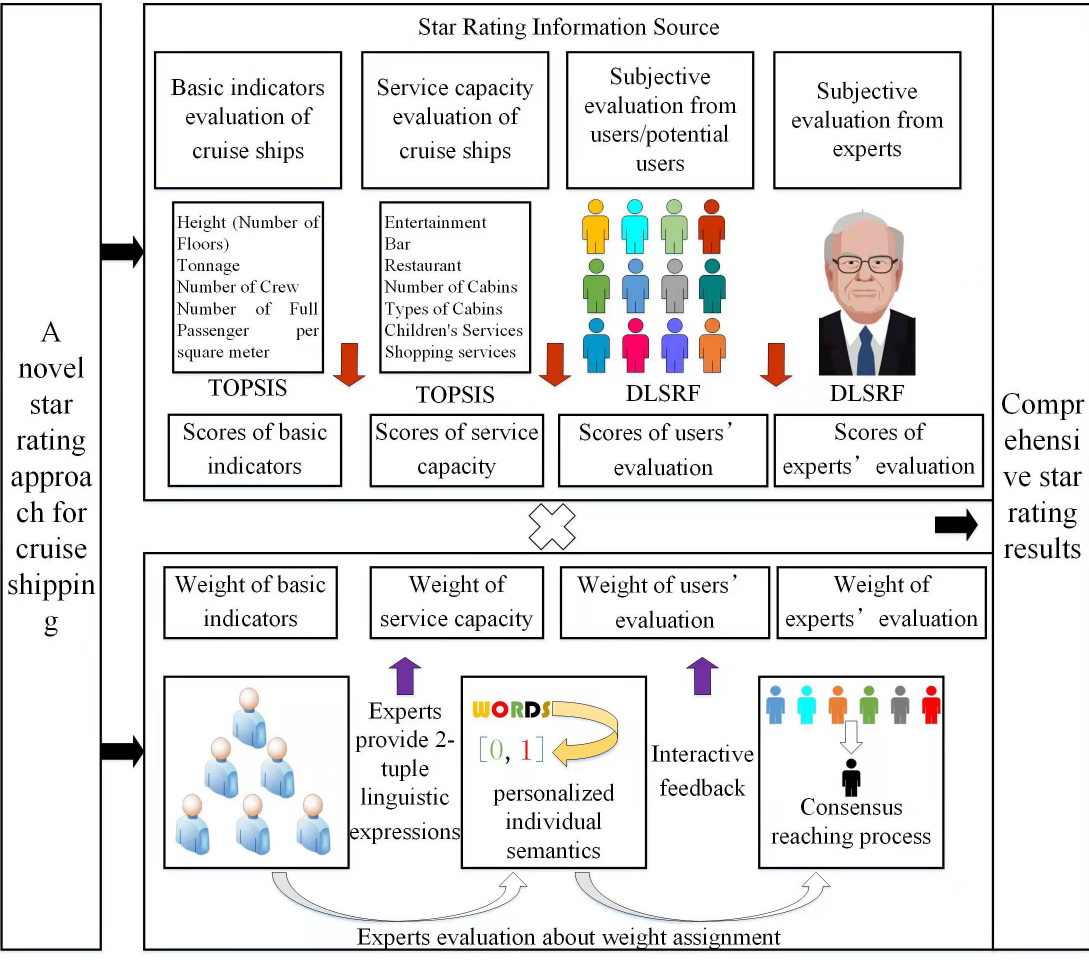
Figure 1. The basic framework of the proposed star rating index